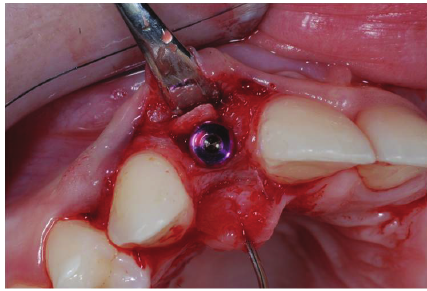
Figure 10: Implant placement in site to the left.